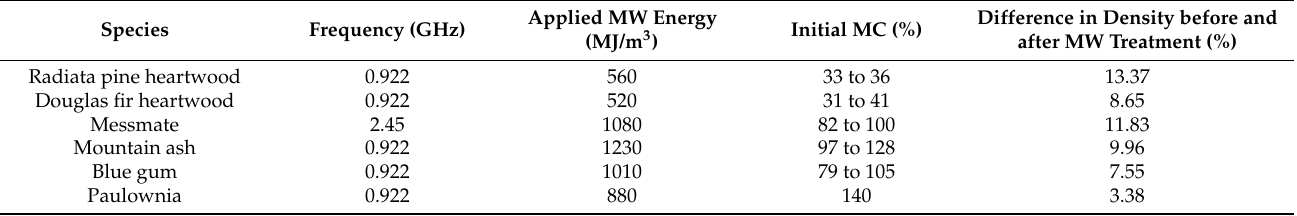
Table 7. Comparison of the wood density before and after MW treatment found by